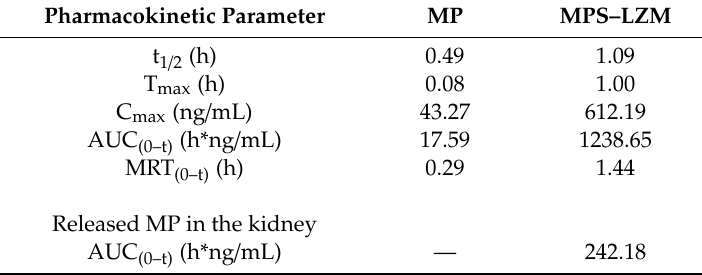
Pharmacokinetic parameters of MP and MPS–LZM in kidneys after a single intravenous